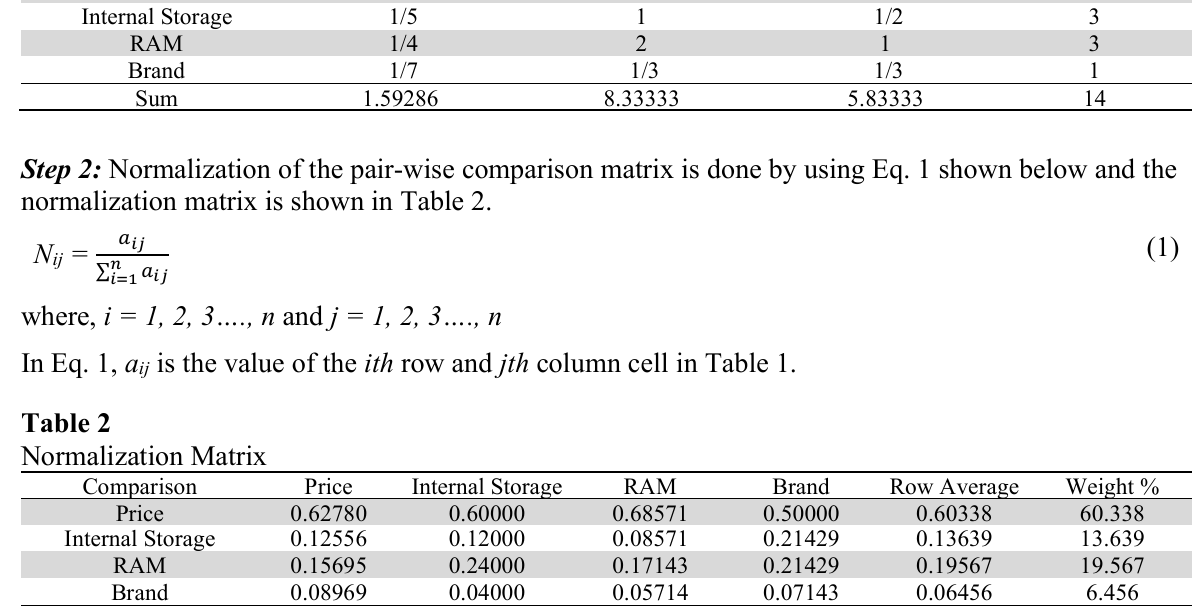
Pair-wise Comparison Matrix of the Criteria’s Comparisons Price Internal Storage RAM